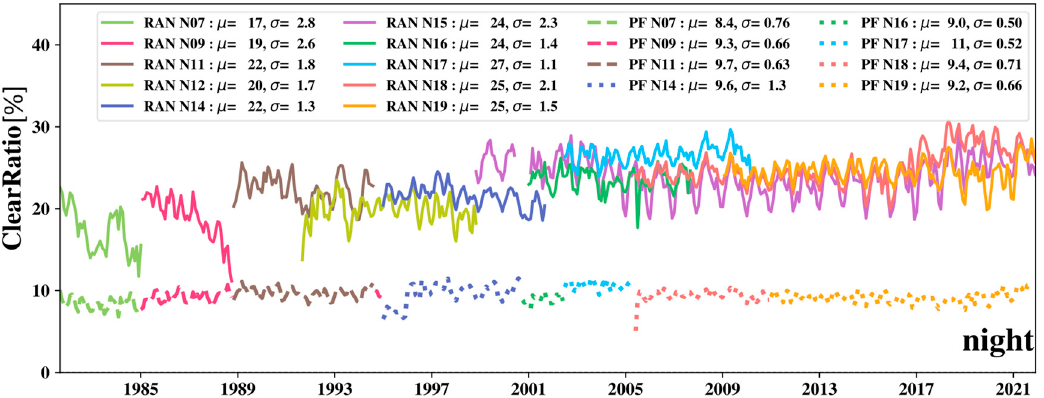
Figure 7. Time series of monthly nighttime Clear-Sky Ratios (CSRs) in RAN2 and PF L3C products. (Data are from the NOAA SQUAM system [21,22]).